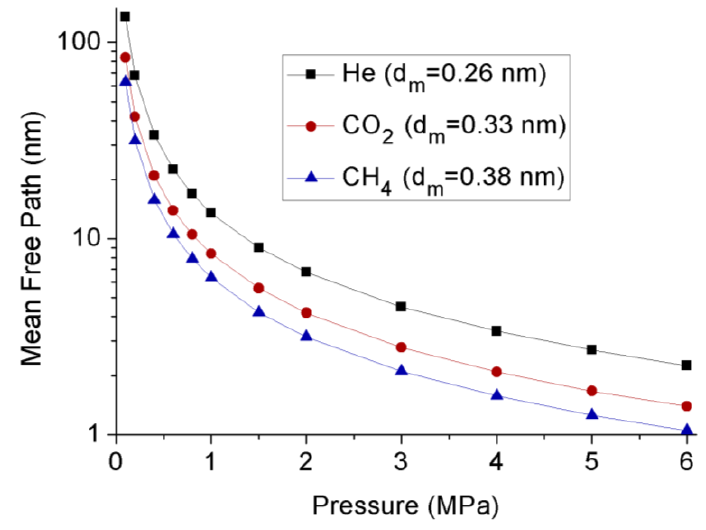
Figure 4. Relationship between mean free path and pressure at 22 °C.